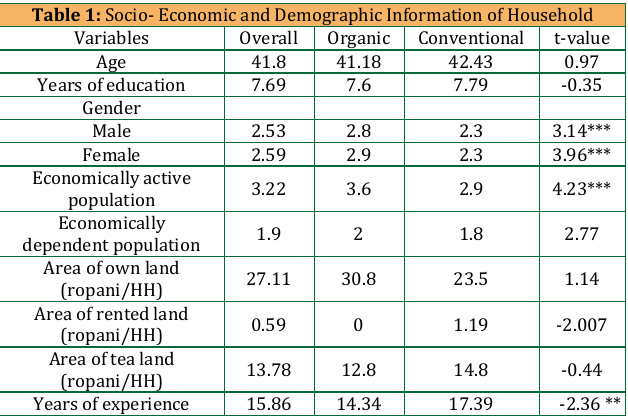
Table 1: Socio- Economic and Demographic Information of Household Variables